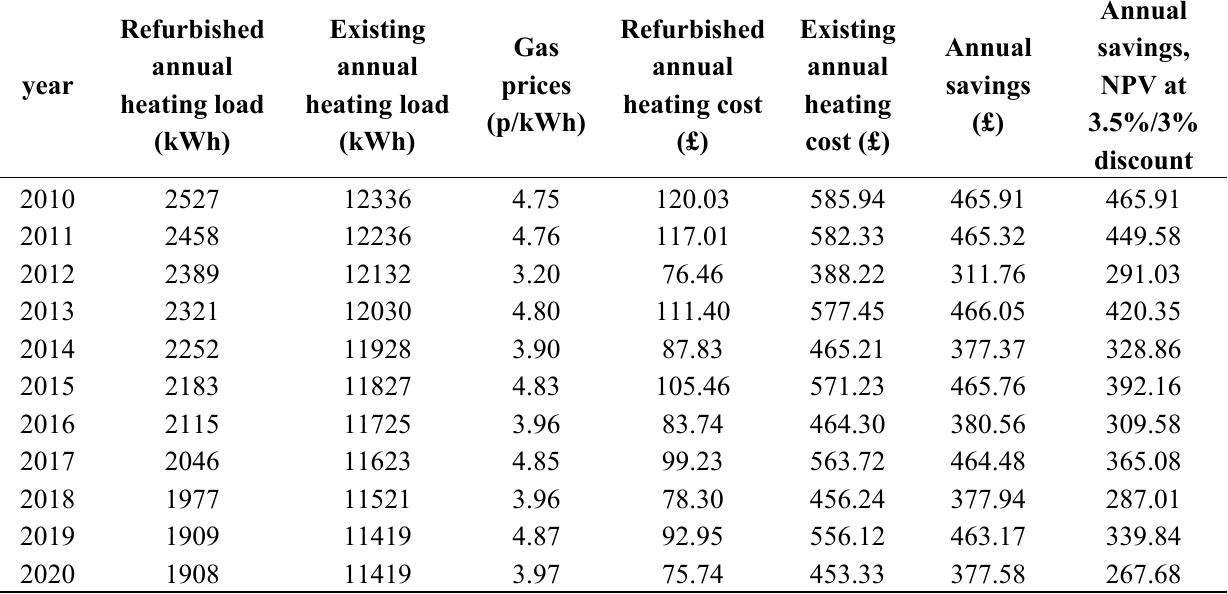
Table 11. Future energy saving costs for constant prices in London for